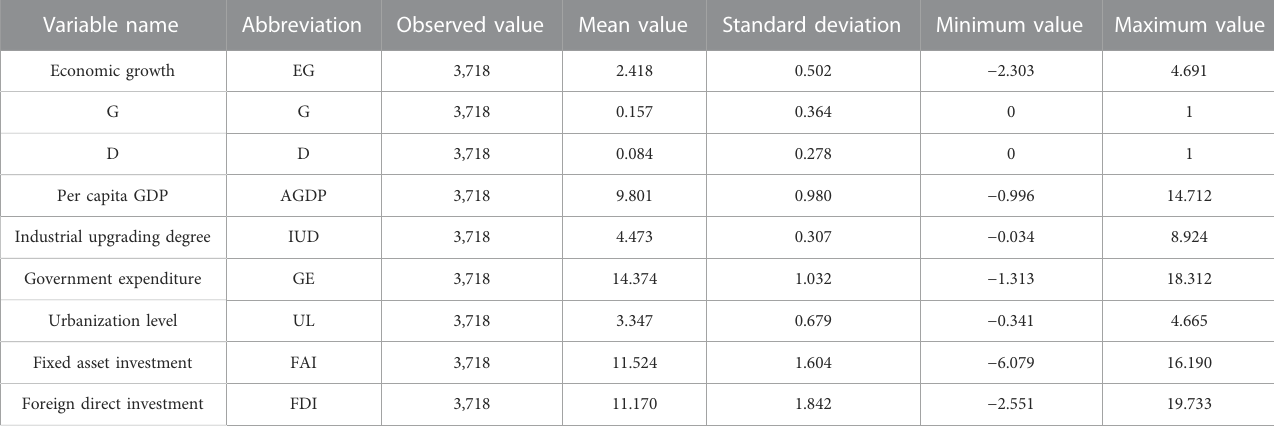
TABLE 1 Descriptive statistics.